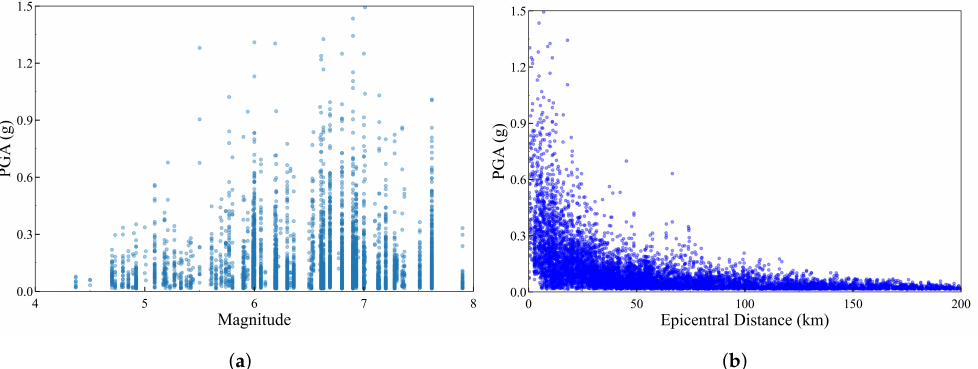
Figure 2. Distribution of the ground motion records according to their PGA and magnitude ( a ) and epicentral distance ( b ).